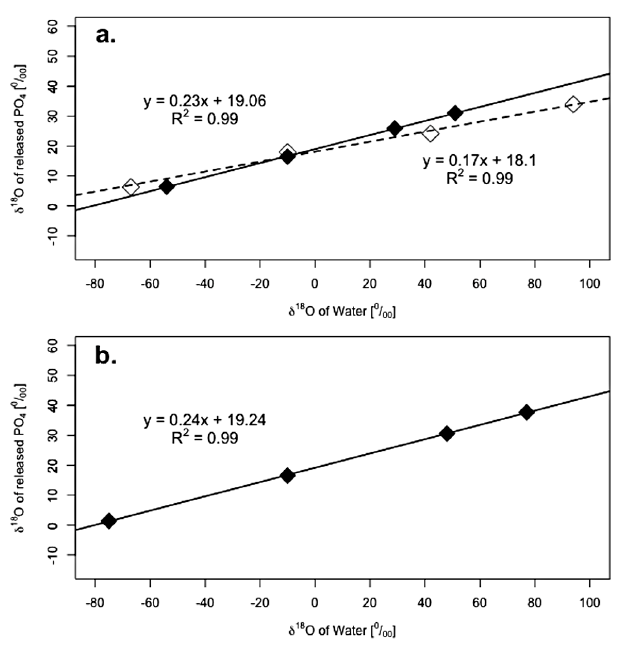
Figure 2. Mean δ 18 O values of released P i ( δ 18 O P ) at different δ 18 O values of water ( δ 18 O W ) from (a) assays with non-purified wheat phytase (dashed line) and purified wheat phytase (solid line) (b) an assay with purified Aspergillus niger